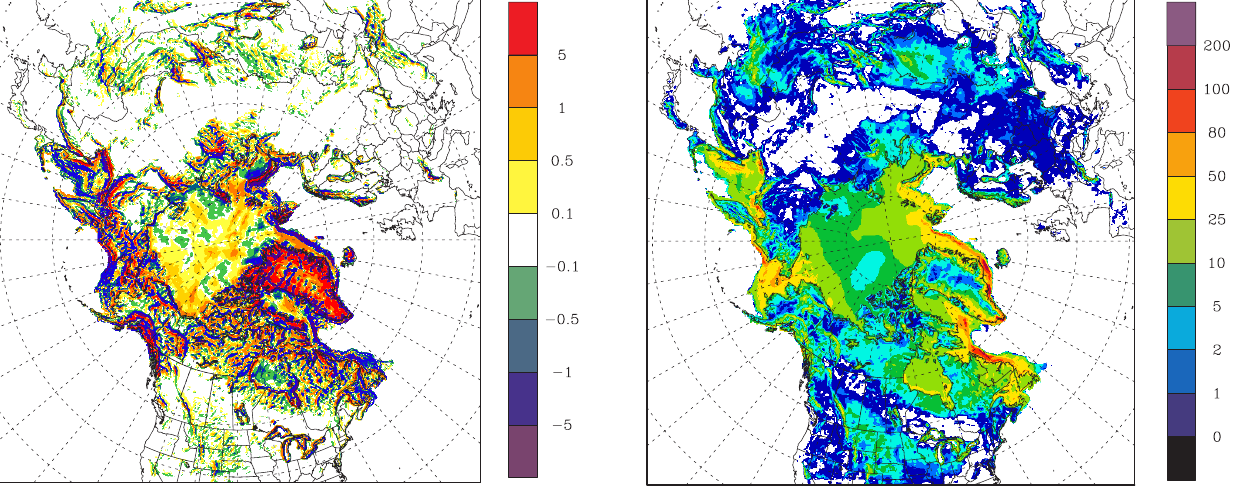
Fig. 8. Winter season blowing snow sublimation from the coupled model over DJF 2006/2007. Units in mm